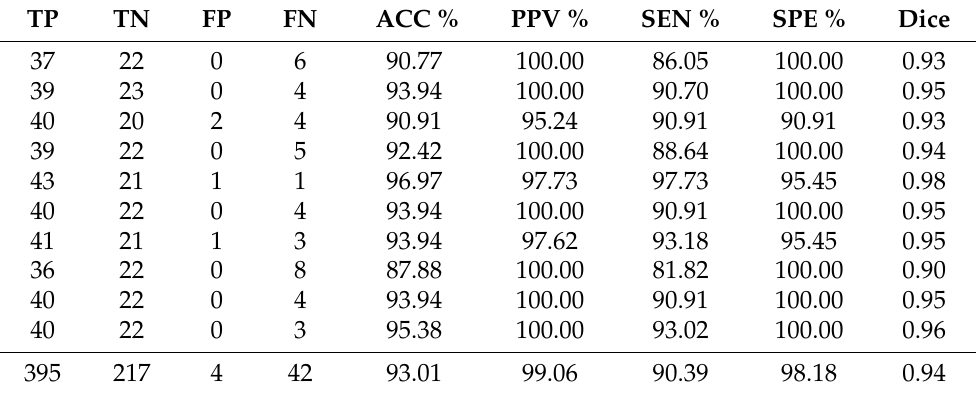
Table 2. SVM with a second order polynomial kernel. The first 10 rows in the table document the performance results for each individual fold. The last row states the averaged performance results.